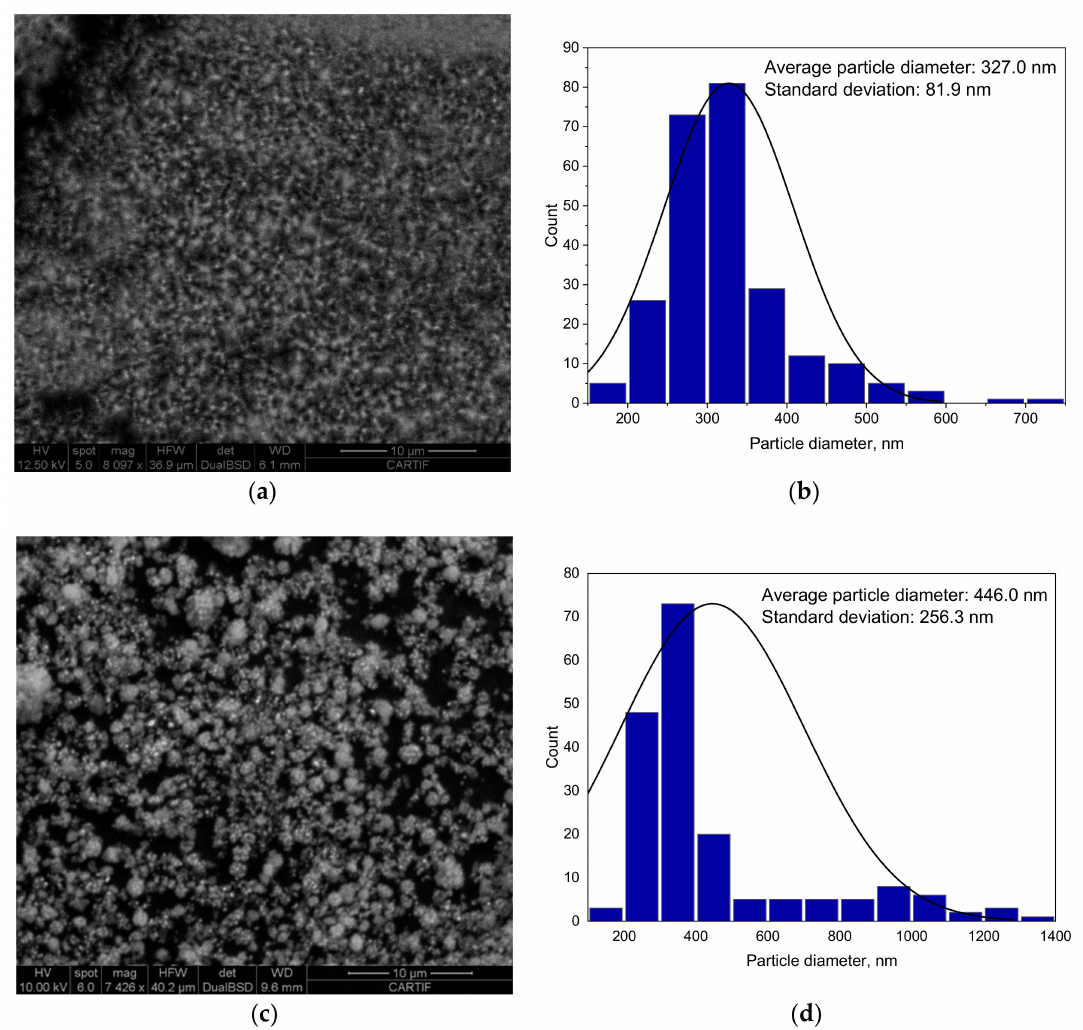
Figure 14. SEM micrograph and histogram of the reduced Ni–Fe–Cu/LDH at 36.9 µ m (HFW) ( a , b ) and after the steam reforming of toluene at 40.2 µ m (HFW) ( c , d